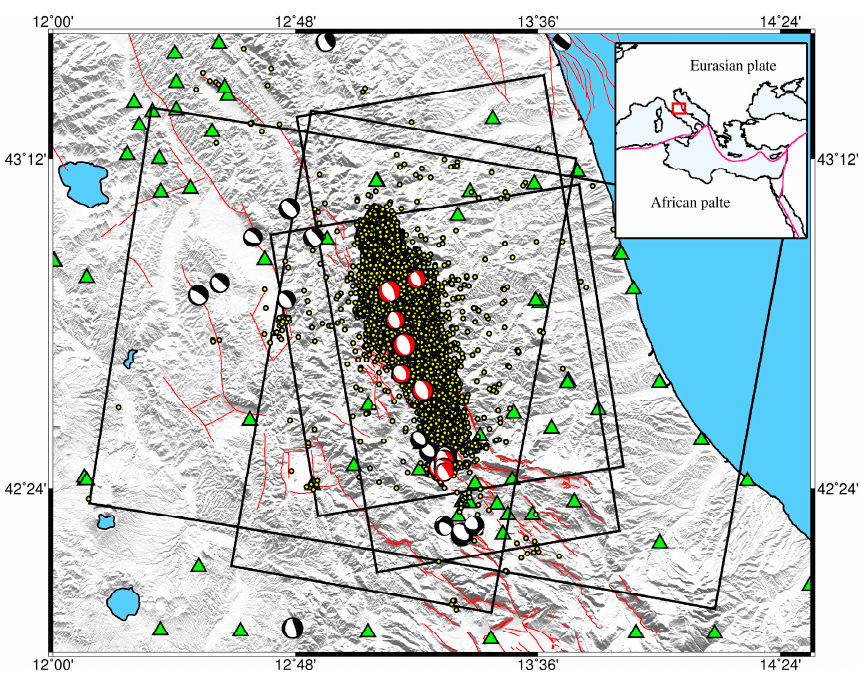
Figure 1. Tectonic setting of the 2016–2017 Central Italy earthquake sequence. Yellow circles are the aftershocks with ML ≥ 2.0 from Institute of Geophysics and Volcanology (INGV) between 24 August 2016 and 30 June 2017. Black boxes outline the spatial coverage of the Sentinel-1 images and Advanced Land Observing Satellite-2 (ALOS-2) images for the 24 August 2016 Amatrice earthquake. Red lines are the active faults from INGV. Green triangle denotes GPS sites used in this paper. The focal mechanism plots represent the moment tensor solutions from Global Centroid Moment Tensor (GCMT). Red focal mechanisms denote the 2016–2017 Central Italy earthquake sequence (Mw ≥ black focal mechanisms denote the history earthquake (1976–2015, Mw 5).